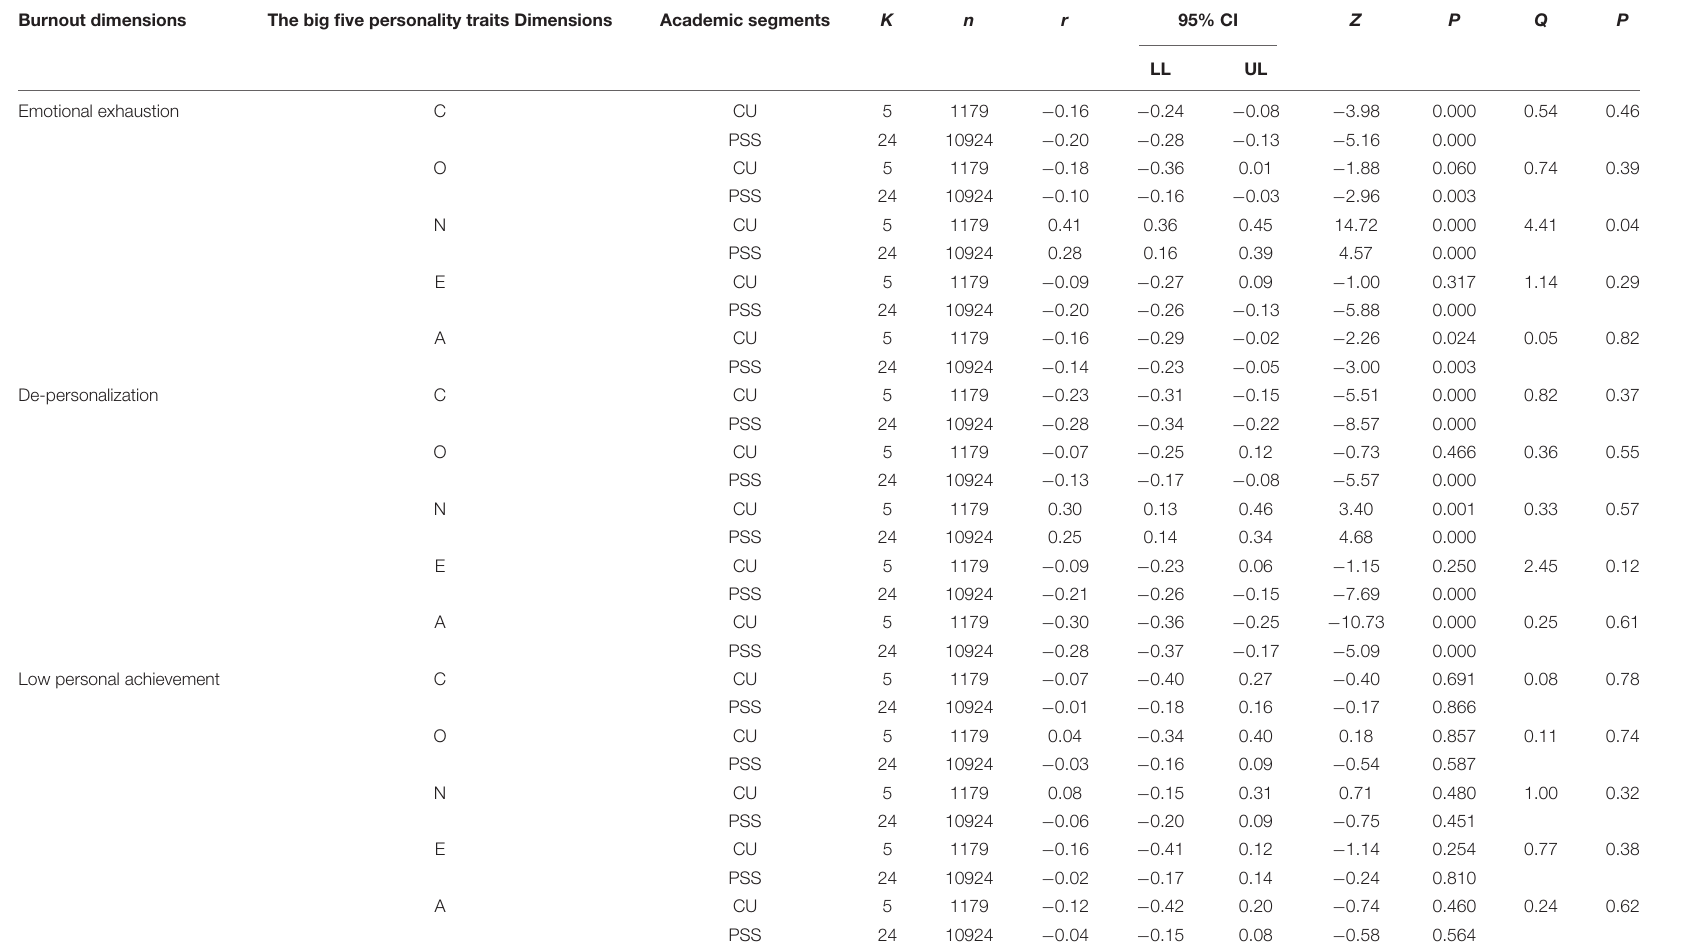
TABLE 5 | Moderating effects of teaching segments on the relationship between big five personality traits and job